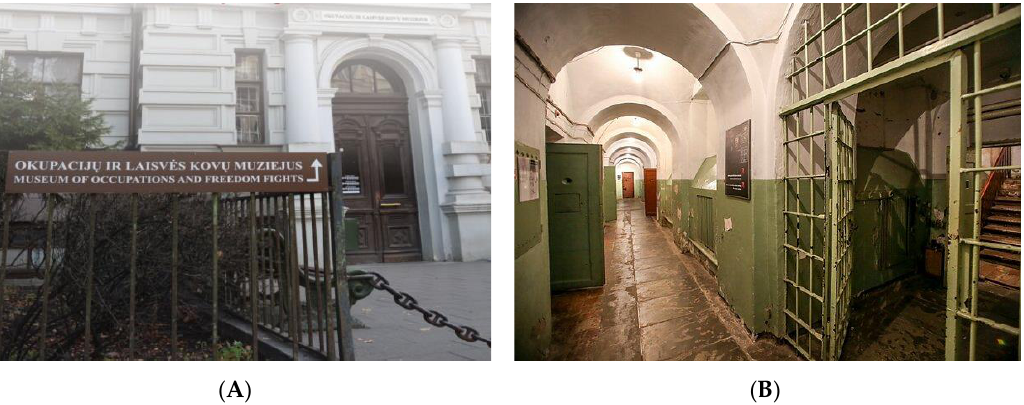
Figure 12. ( A ) Museum of Occupations and Freedom Fights in Vilnius, Lithuania. Available online: https://tinyurl.com/39dvbz9f; https://tinyurl.com/2p88539s (accessed on 19 January 2022); ( B ) Museum of Occupations and Freedom Fights in Vilnius, Lithuania. Available online: https://tinyurl.com/39dvbz9f; https://tinyurl.com/2p88539s (accessed on 19 January 2022).